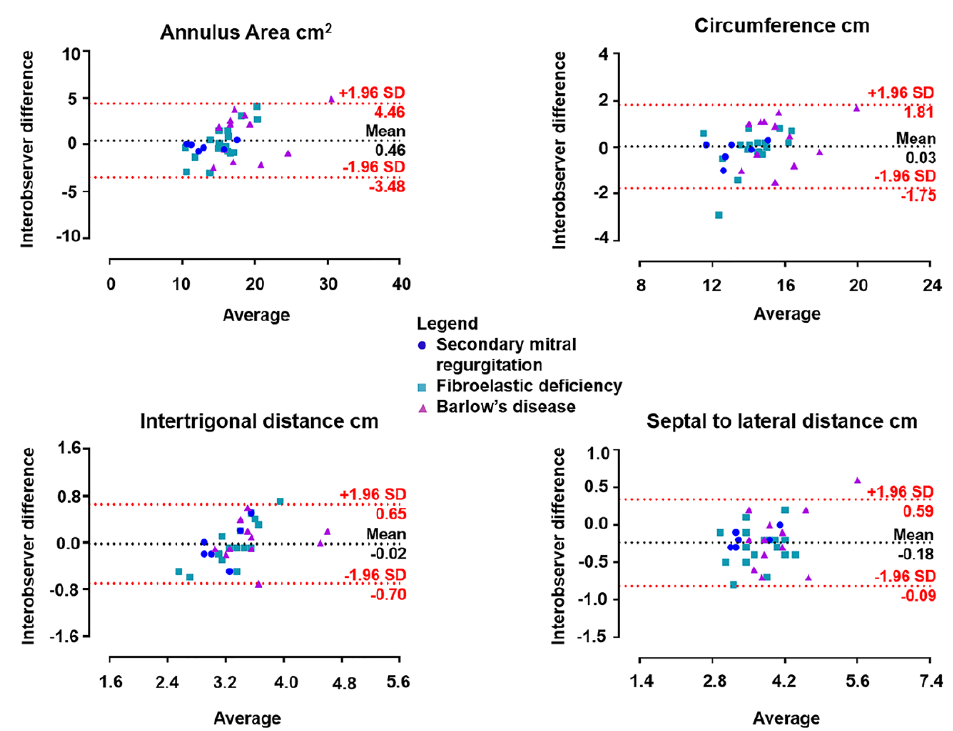
Figure 2. Bland–Altman plots of inter-observer difference using 4D Auto MVQ. Comparison of D-shaped annulus dimensions of mitral valve regurgitation with secondary MR, fibroelastic deficiency and Barlow’s disease.